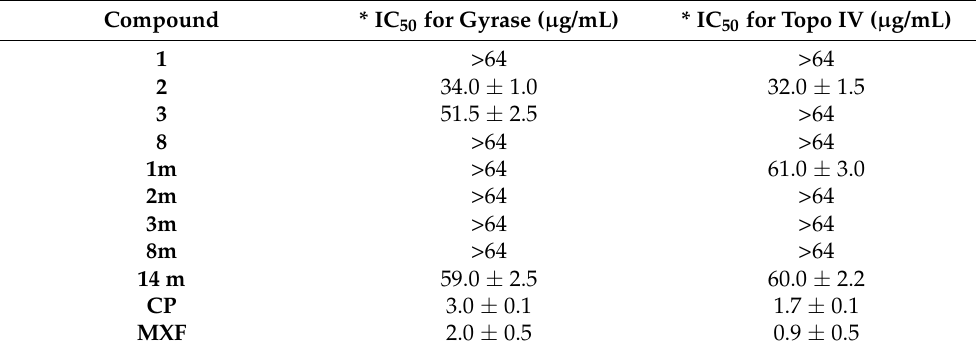
Figure 1. Electrophoretic analysis of S. aureus DNA gyrase supercoiling assay showing relaxed (R) and supercoiled DNA (S) bands at concentrations of 64, 32, 8, and 0.5 μg /mL of tested conjugates 1 – 3 , 8 , 1m – 3m , 8m , and 14m . Table 5. IC 50 values for the inhibition of catalytic activities of S. aureus